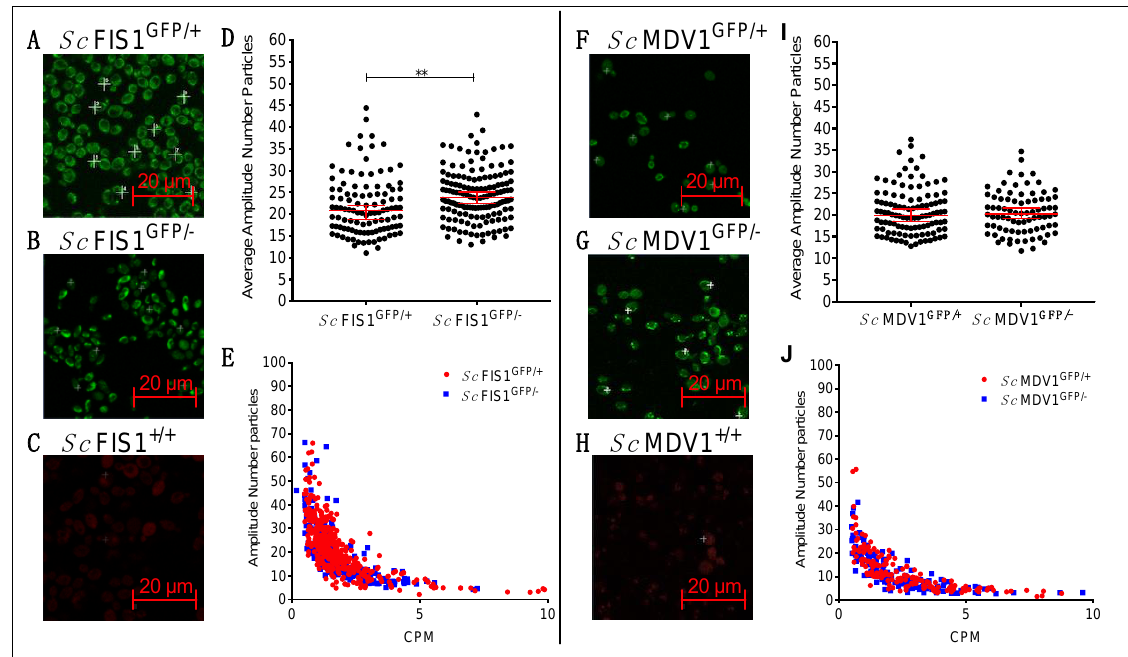
Figure 2. Detection of increased Fis1p-GFP and Mdv1p-GFP in heterozygote yeasts by FCS. Sample images of Sc FIS1 GFP/+ ( A ), Sc FIS1 GFP/ − ( B ) and Sc FIS1 +/+ ( C ) show yeast cells of an OD600 of 0.5 in SD media containing 2% glucose imaged under simultaneous laser excitation at 488 nm and 561 nm (Scale bar = 20 μm) and at positions indicated by the crosses. Panel ( D ) presents the scatter plots showing the heterogenous expression of Fis1p-GFP measured in single cells of Sc FIS1 GFP/+ ( n = 107) and Sc FIS1 GFP/ − ( n = 145) cells. In panel ( E ), the correlation between the CPM and amplitude values reveals no technical artefacts for FCS measurements taken in both cell lines ( Sc FIS1 GFP/+ , R 2 = 0.41 and Sc FIS1 GFP/ − , R 2 = 0.43). Images ( F – H ) show exponentially growing Sc MDV1 GFP/+ ( F ), Sc MDV1 GFP/+ ( G ) and Sc MDV1 +/+ ( H ) yeast cells in SD media containing 2% glucose and under simultaneous laser excitation at 488 nm and 561 nm and at positions indicated by the crosses (Scale bar = 20 µ m). Scatter plot in panel ( I ) shows the heterogenous levels of Mdv1p-GFP abundance measured in single cells of Sc MDV1 GFP/+ ( n = 108) and Sc MDV1 GFP/ − ( n = 81) populations. In panel ( J ), the correlation of CPM to amplitude values reveals no technical artefacts for measurements taken in all cell types ( Sc MDV1 GFP/+ , R 2 = 0.46 and Sc MDV1 GFP/ − , R 2 = 0.49). Error bars show the 95% confidence intervals and the median value. Statistical significance was calculated using Mann–Whitney two-tailed t -test. ** represents significance at the 0.01 level.